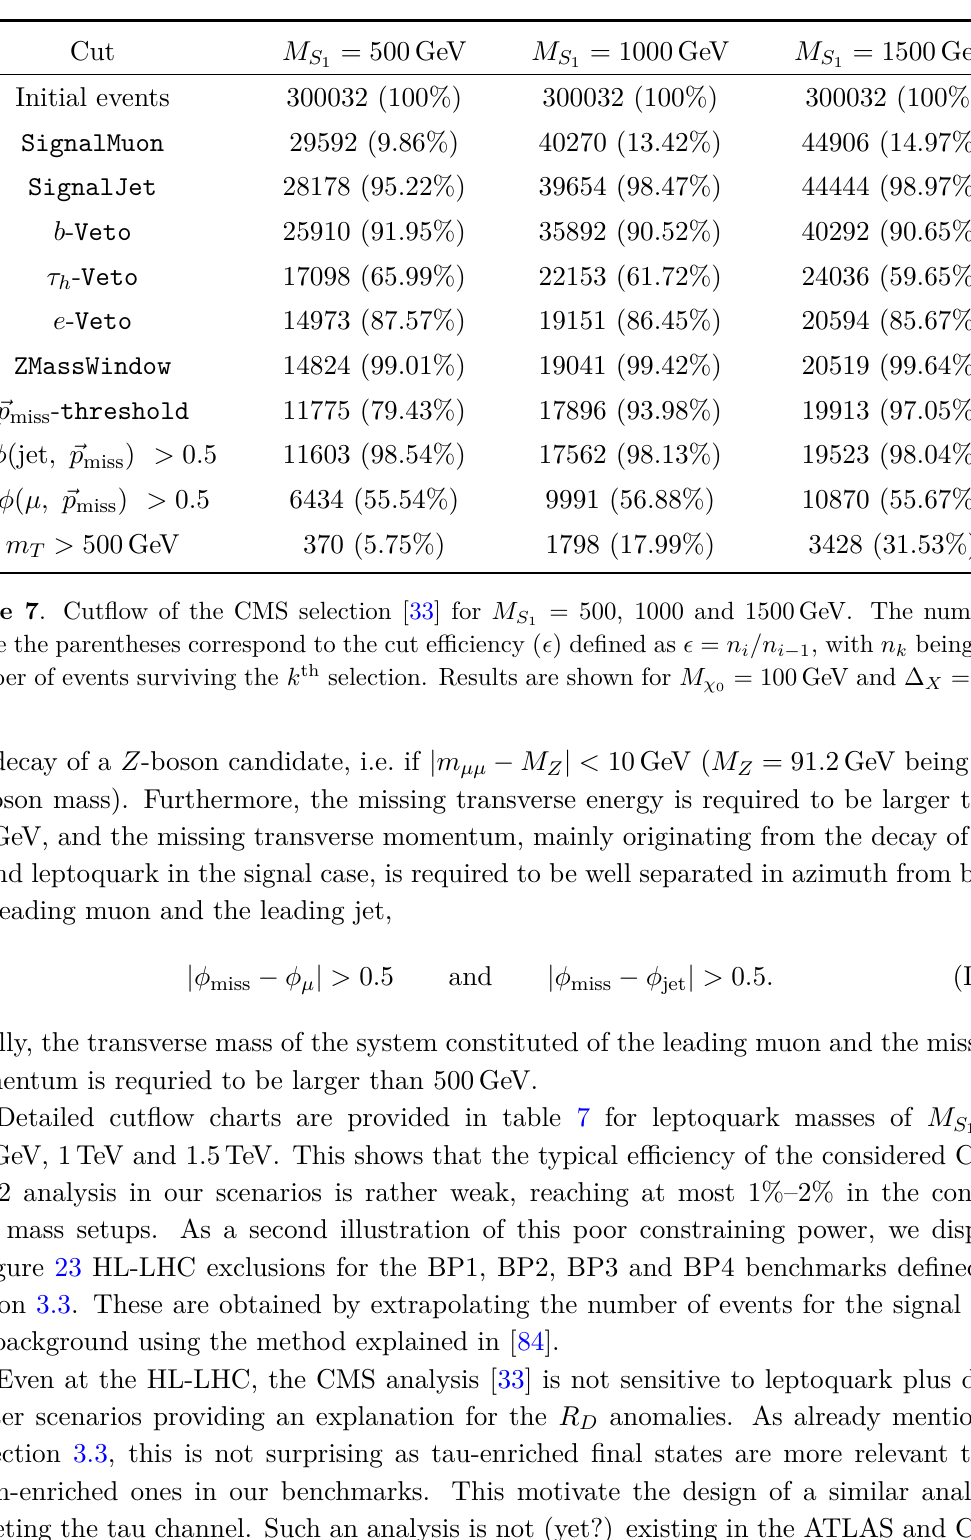
Table 7 . Cutflow of the CMS selection [33] for M S inside the parentheses correspond to the cut efficiency ( (cid:15) ) defined as (cid:15) = n i /n i − 1 , with n k being the number of events surviving the k th selection. Results are shown for M χ